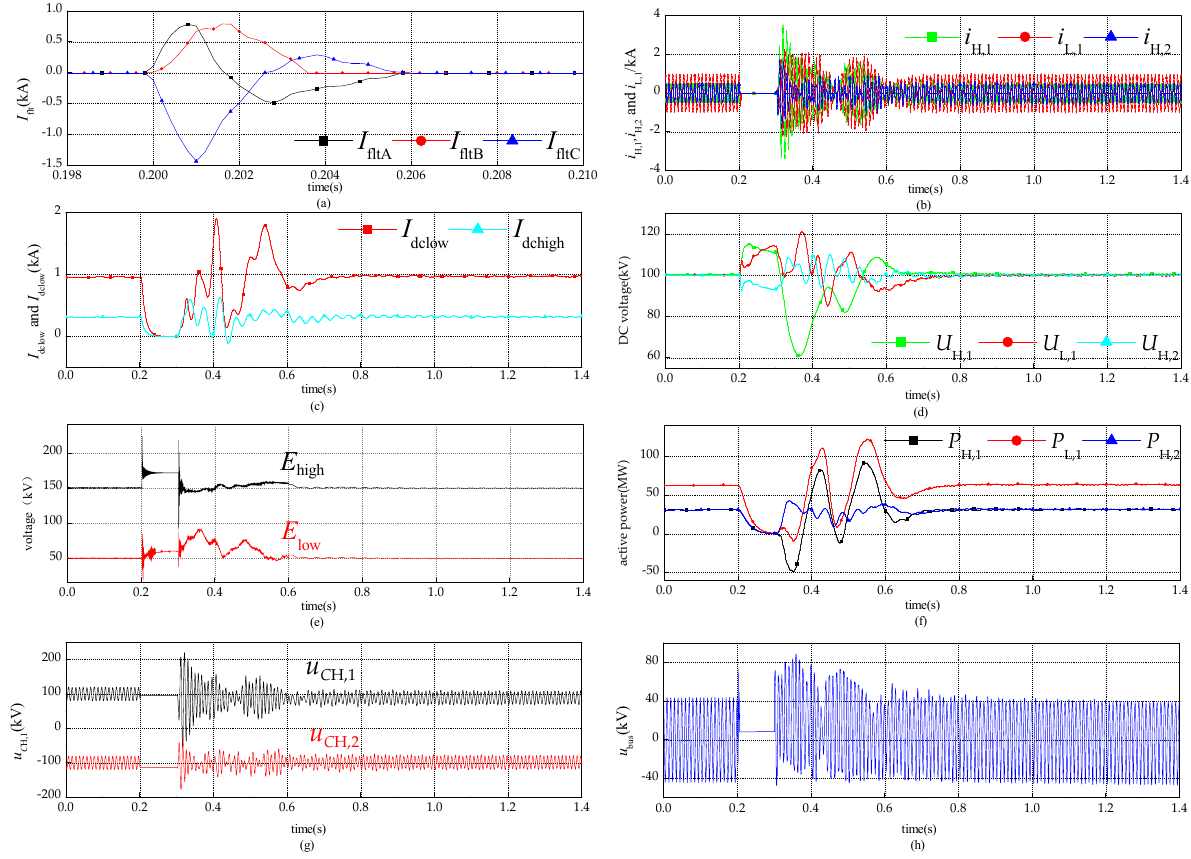
Figure 7. Simulation results of fault and recovery process: ( a ) Three-phase short circuit currents; ( b ) A phase AC output current of MMCs; ( c ) DC currents of high-voltage and low-voltage DC grids respectively; ( d ) DC voltages of MMCs; ( e ) DC voltages of high-voltage and low-voltage DC grids respectively; ( f ) active power transmitted by MMCs; ( g ) voltages of C H,1 and C H,2 ; ( h ) A phase voltage of the AC